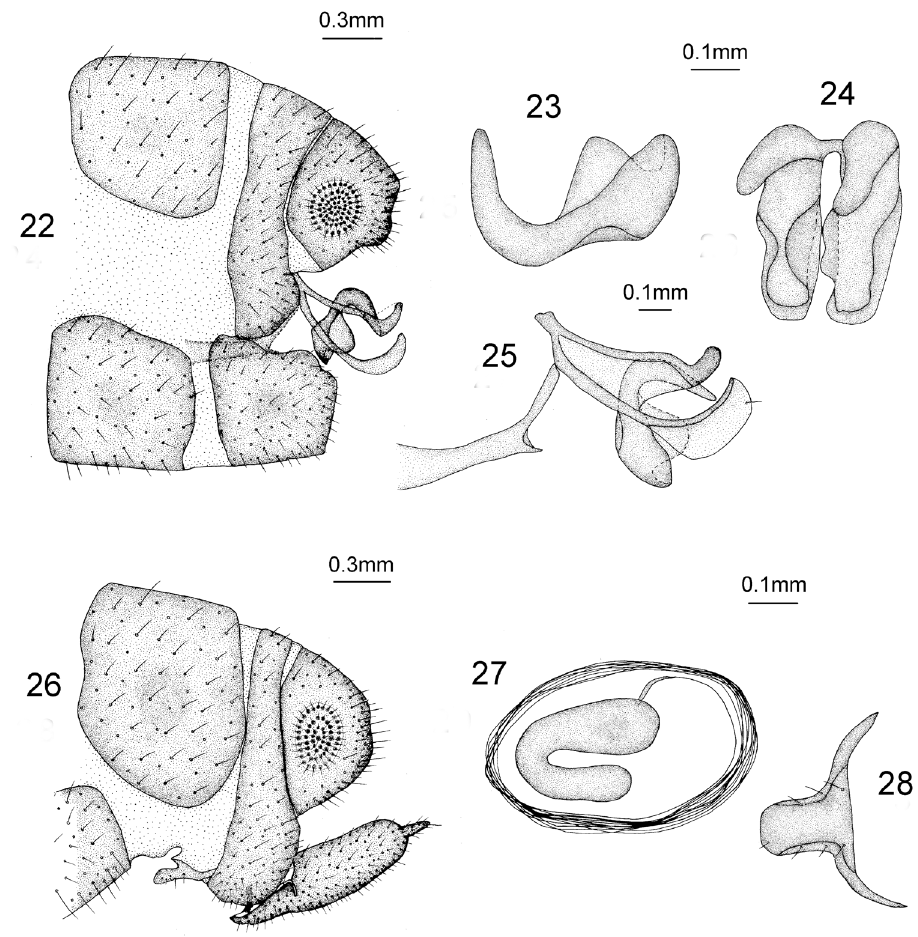
Figures 22–28. Heterosmylus wolonganus Yang, 1992. Male: 22 terminalia, lateral view 23 mediuncus, lateral view 24 mediuncus, dorsal view 25 genitalia, lateral view. Female: 26 terminalia, lateral view 27 spermatheca, lateral view 28 8 th sternite, ventral view. gonocoxite fusiform in lateral view; 9 th gonostylus long in lateral view; spermatheca bent into C-shape.